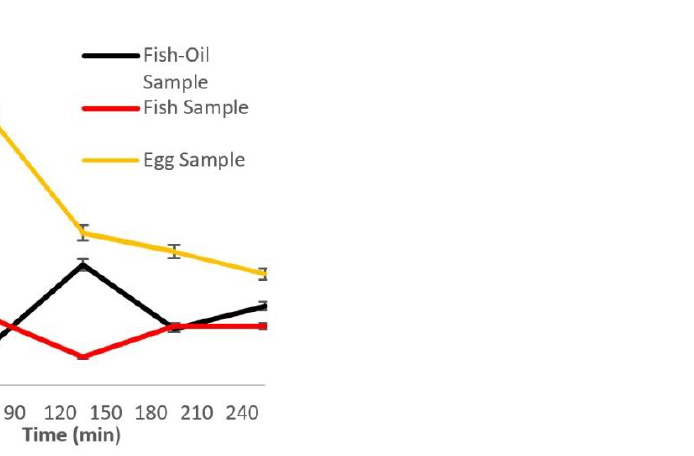
Table 2. TBARS results before and after digestion.